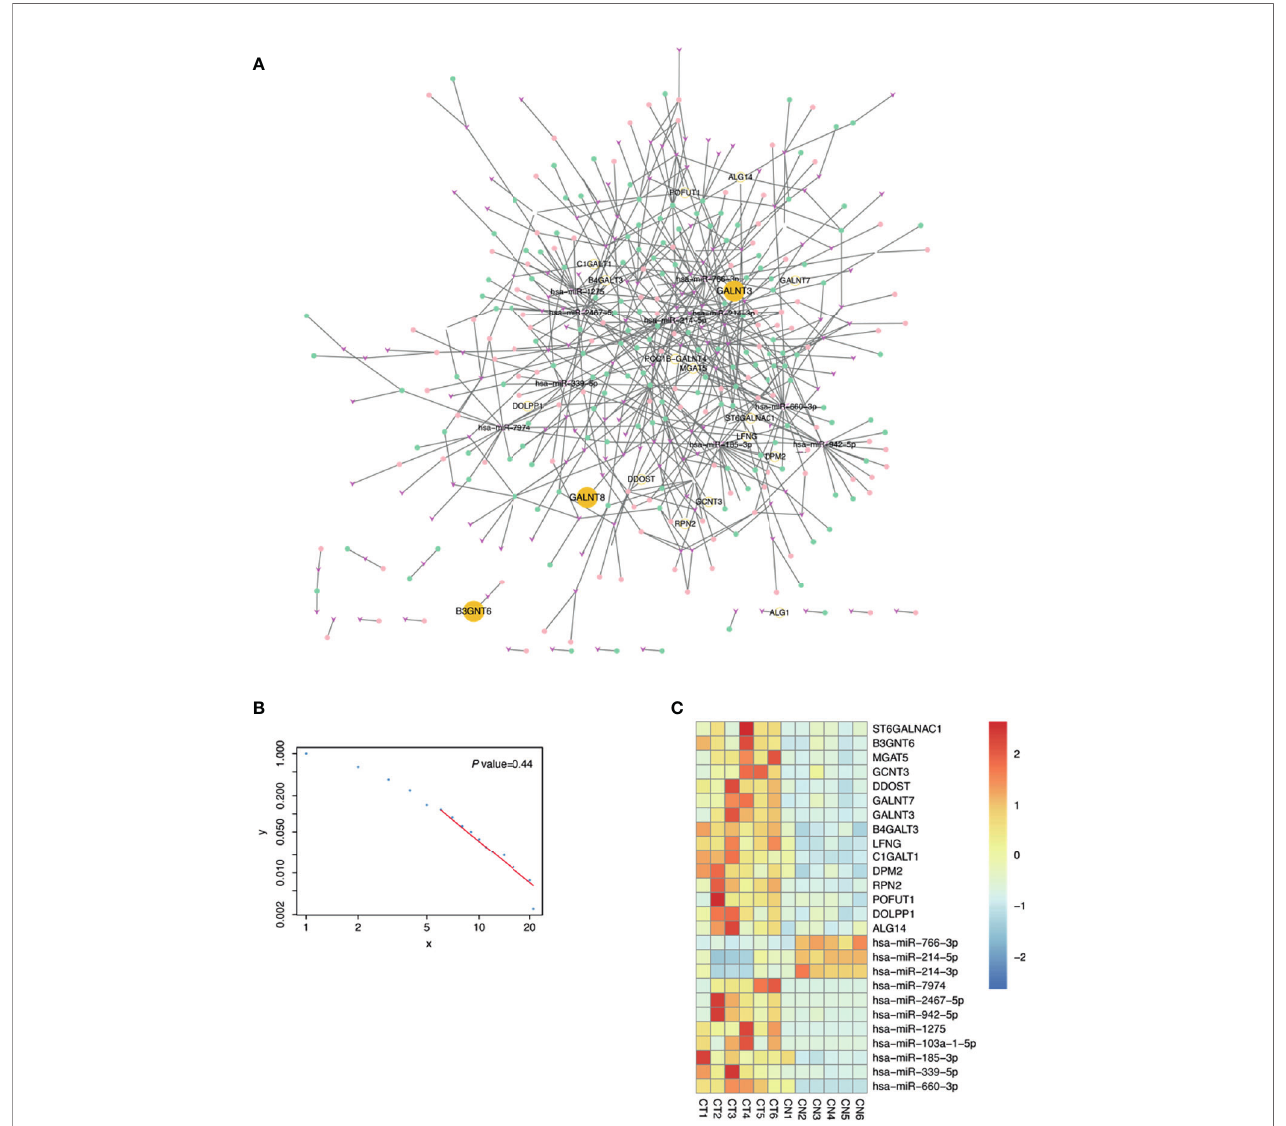
FIGURE 2 | Construction of glycosylation related competing endogenous RNA (ceRNA) network. (A) The ceRNA network related to glycosylation. Fuchsia v shapes represent microRNA (miRNA); green dots, long noncoding RNA (lncRNA); pink dots, circular RNA (circRNA); yellow dots, messenger RNA (mRNA). (B) Power law scatter plot for ceRNA network. (C) Top 10 mRNA – miRNA interactions of ceRNA network in pro fi cient mismatch repair (pMMR) colorectal adenocarcinoma (CRAC) tissues (CT1-6) and non-tumor tissues (CN1-6) were visualized in